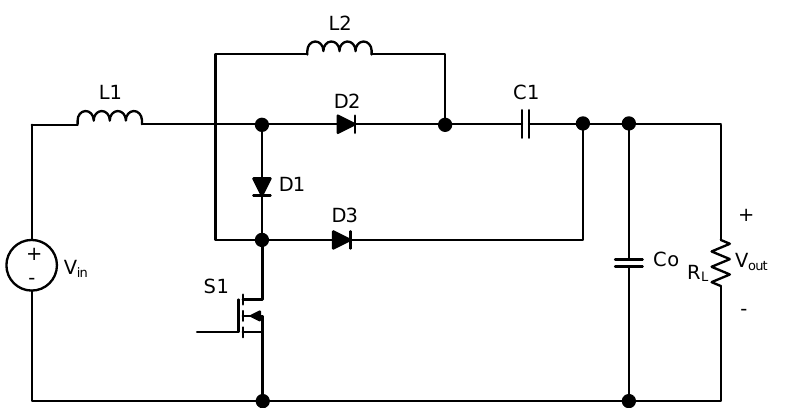
Figure 1. Topology of the proposed DC-DC boost converter.